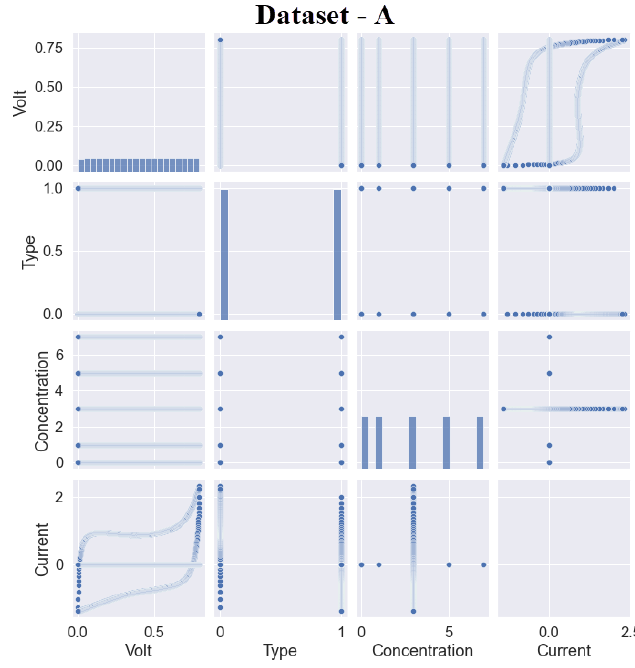
Figure 11. Pair distribution plots of Dataset A.